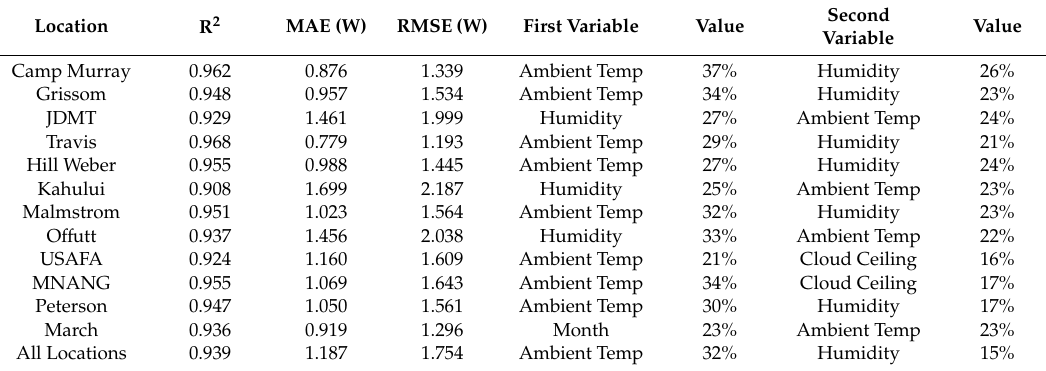
Table 6. Accuracy metrics and variable importance rankings by